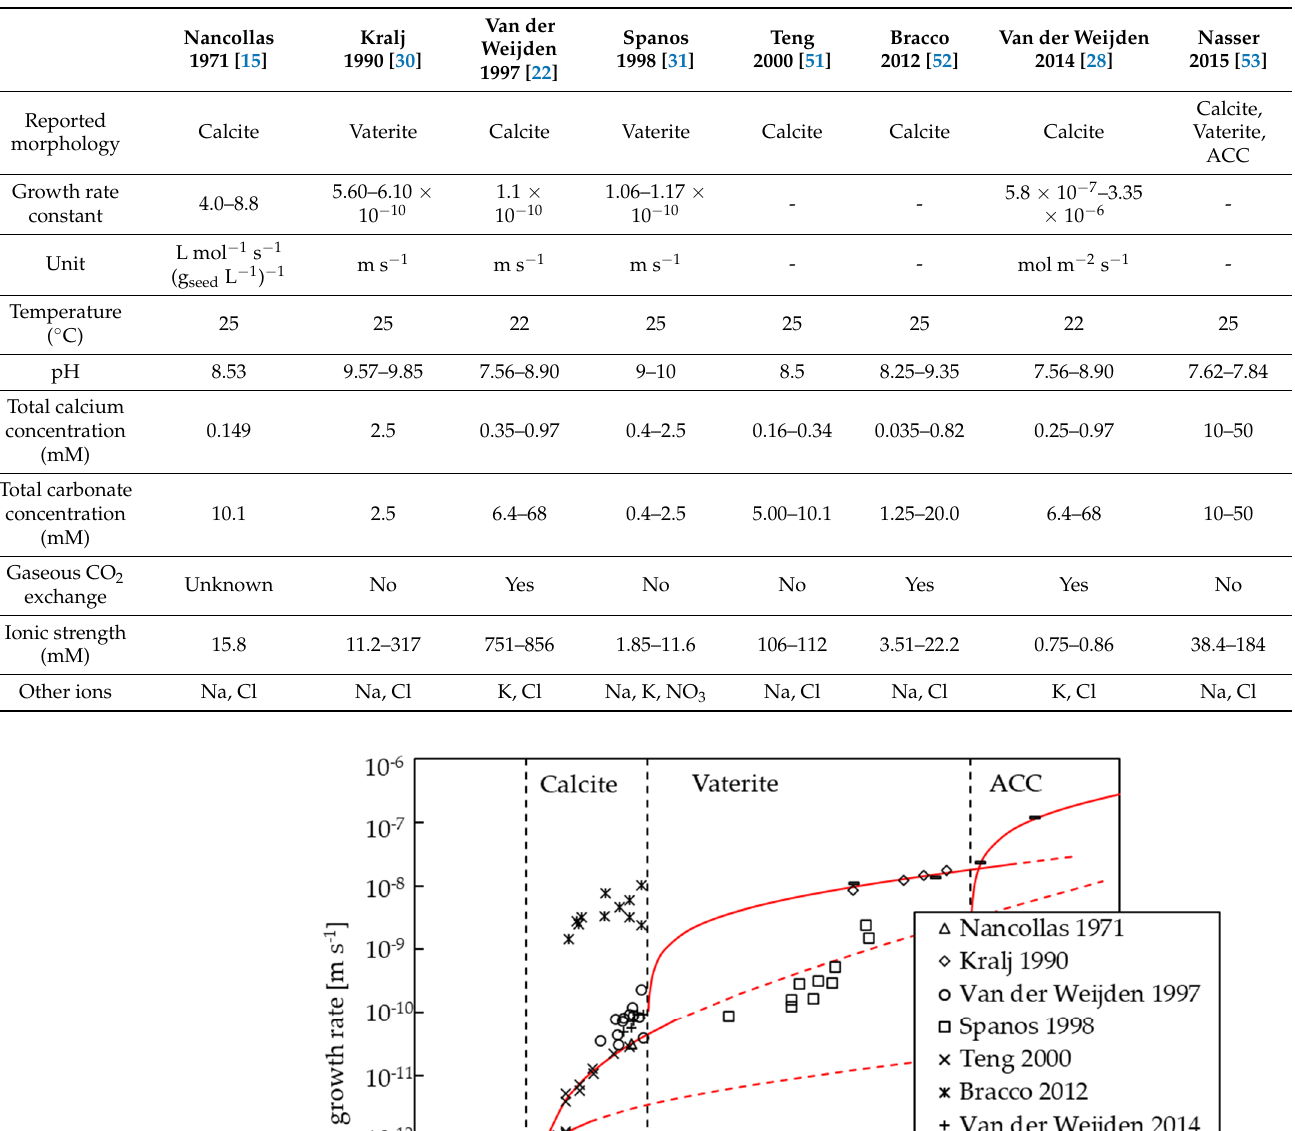
Table 2. Experimental conditions for the selected data points in Figure 1.